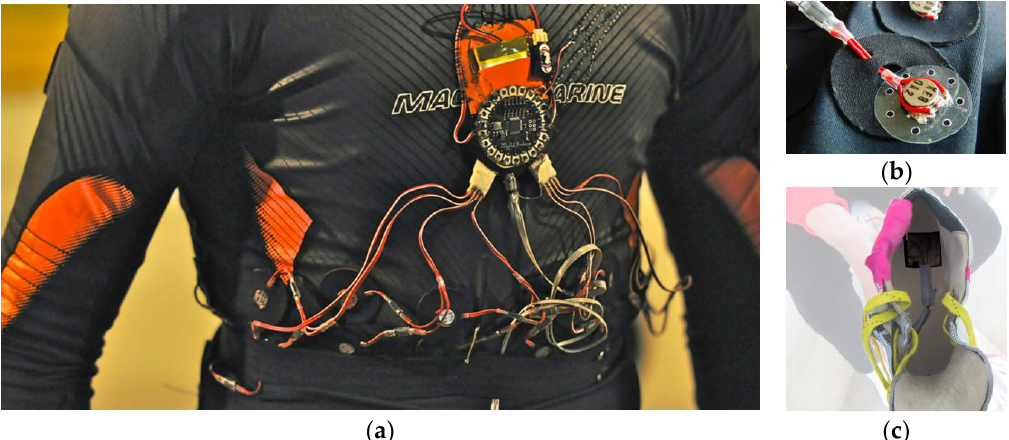
Figure 3. ( a ) The final prototype mounted on stretching apparel ( b ) mounting the vibro-tactile element (tactor) and ( c ) pressure sensor mounted inside the shoe of a